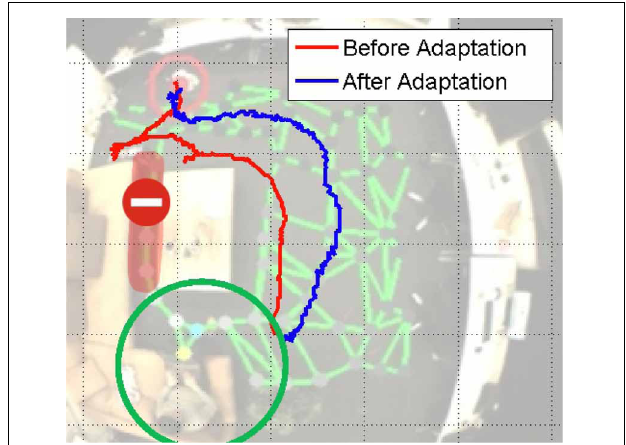
FIGURE 7 | Experiment of map adaptation. The green circle denotes the target position. The area masked in red with a red ban sign shows the narrow path of 25cm width, where the robot cannot walk through. The red and blue trajectories show how the robot navigates before and after the map adaptation.